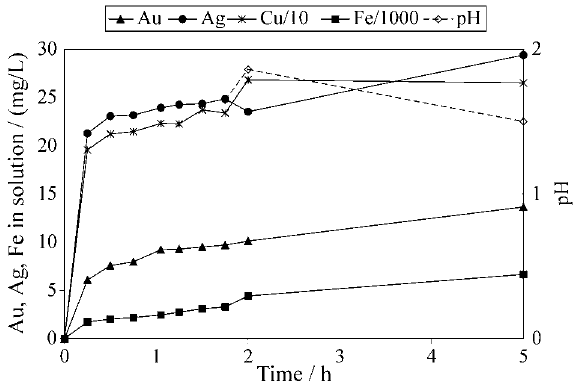
Figure 5. Product cyanidation using 0.67% NaCN solution; 1 kg of product, 3 L of solution, 30 g of lime; 10 g NaCN were added to the pulp at time A. Au recovery = 55.7%; Ag recovery = 72.7%.